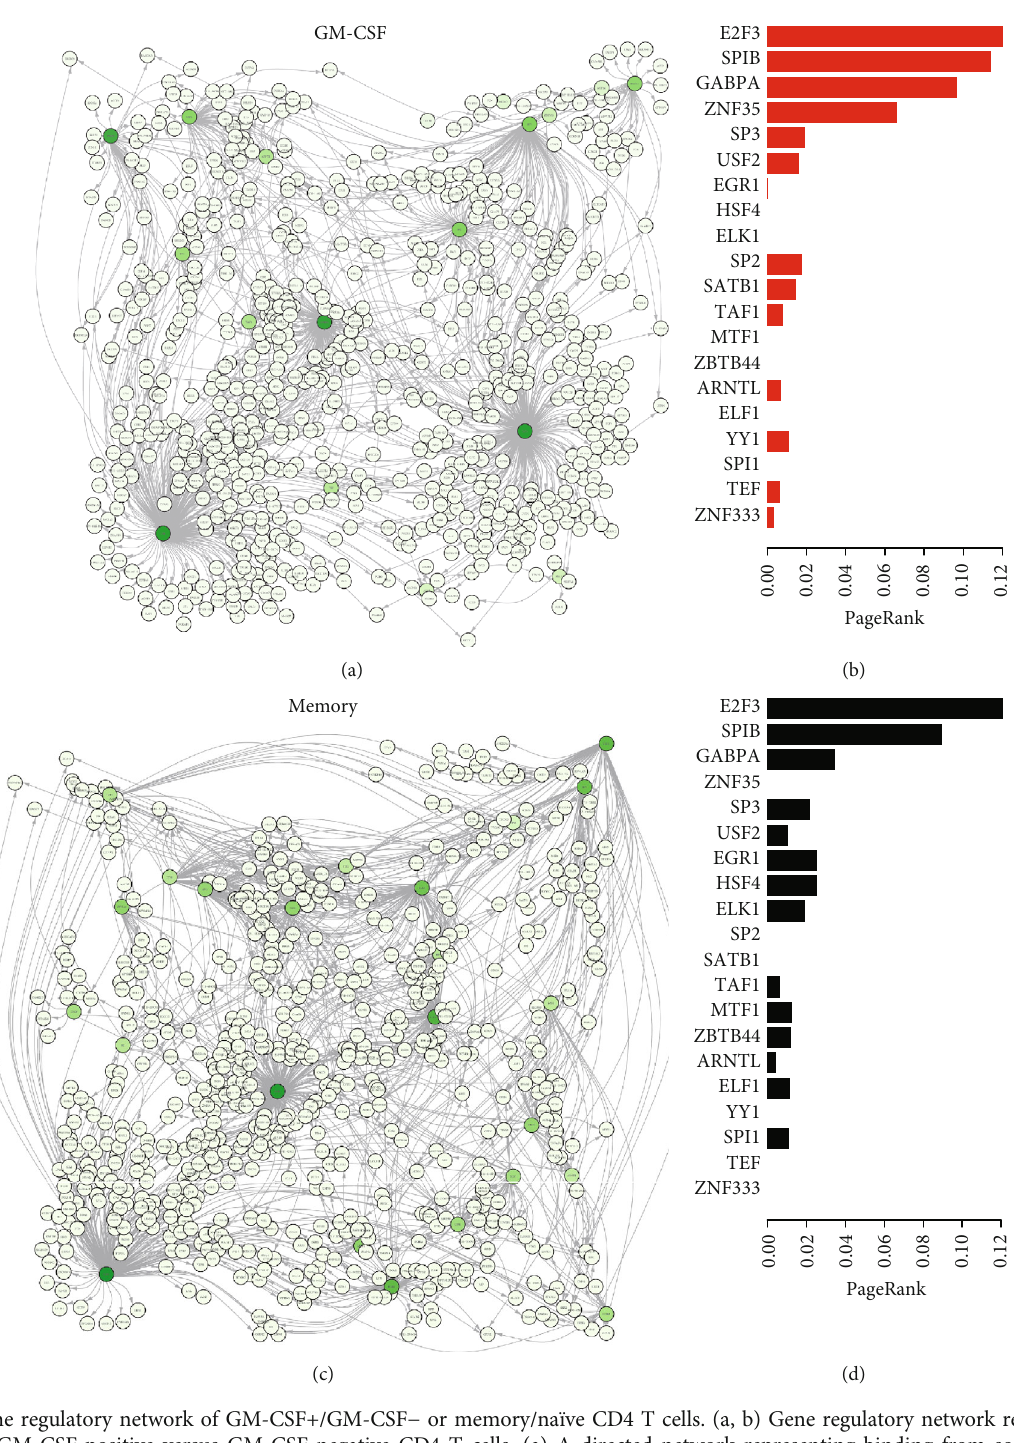
Figure 8: Gene regulatory network of GM-CSF+/GM-CSF − or memory/naïve CD4 T cells. (a, b) Gene regulatory network re fl ecting the signatures of GM-CSF-positive versus GM-CSF-negative CD4 T cells. (a) A directed network representing binding from source TFs to target peaks assigned to the indicated gene is shown. Source nodes were selected as described (Figure 7, key TFs), and target nodes were selected to be either di ff erentially accessible (as a peak assigned to the respective node gene) and/or to be di ff erentially expressed on the mRNA level in the GM-CSF+/GM-CSF − contrast. To calculate the PageRank [51] as a measure of importance of the TFs (with TFs in fl uencing more genes being more important), the edges were fi rst inverted (not displayed), and the computed PageRank value is represented by the color scale (light to dark green for lower to higher PageRank). (b) Those TFs having a PageRank value higher than the 99-percentile in either the GM-CSF and/or the memory cell network and their corresponding PageRank value in the GM-CSF network are displayed. (c, d) Same as (a, b), but for the memory/naïve CD4 T cell